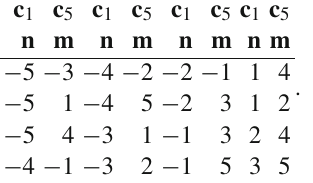
Table 2 Solutions for the charged-lepton mass matrix in terms of the order 3